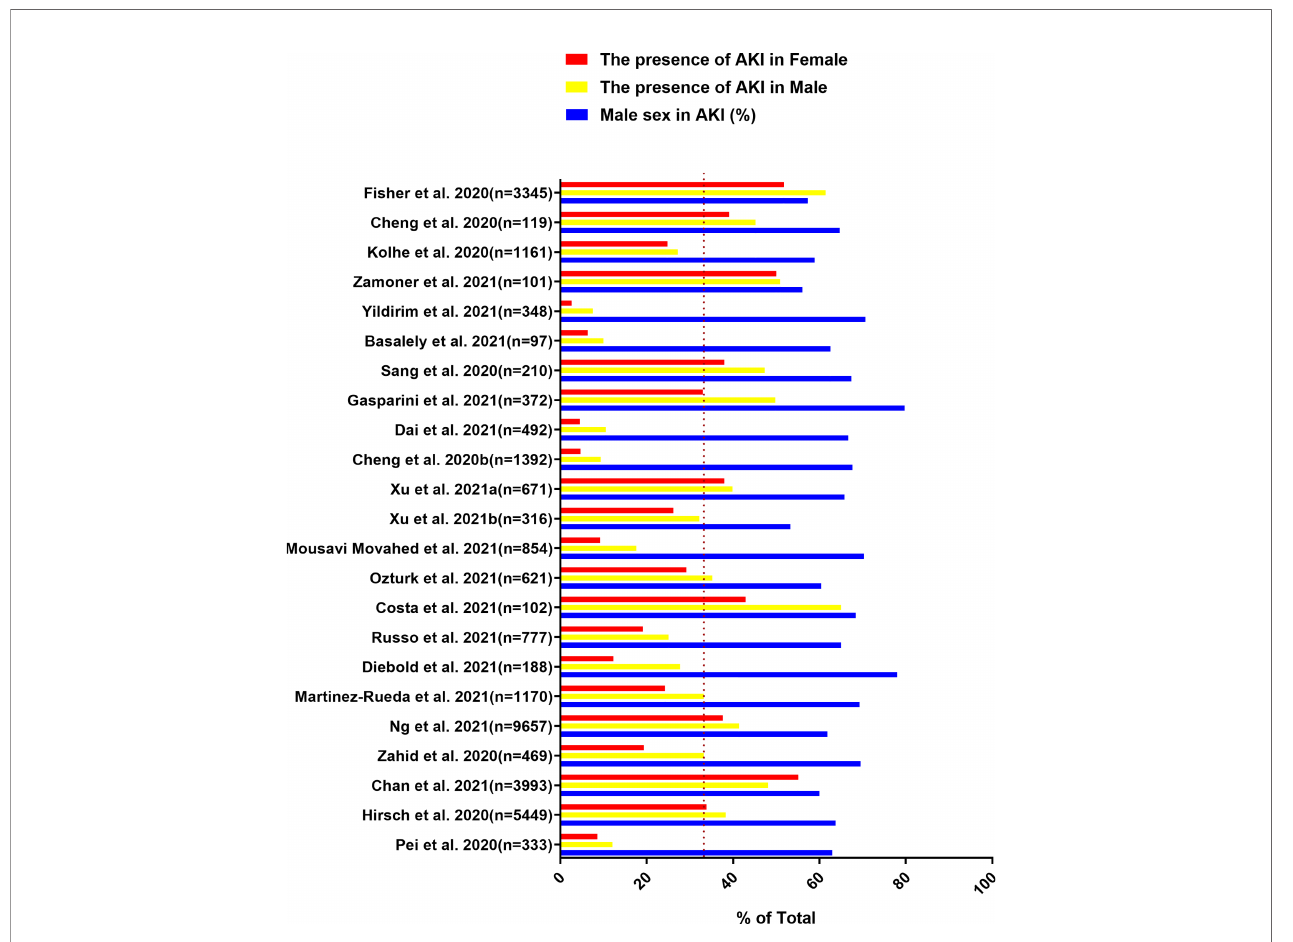
FIGURE 2 | Data are extracted from 23 studies on COVID-19 patients, including the total number of patients included, the proportion of males in AKI patients, the incidence of AKI in male patients and the incidence of AKI in female